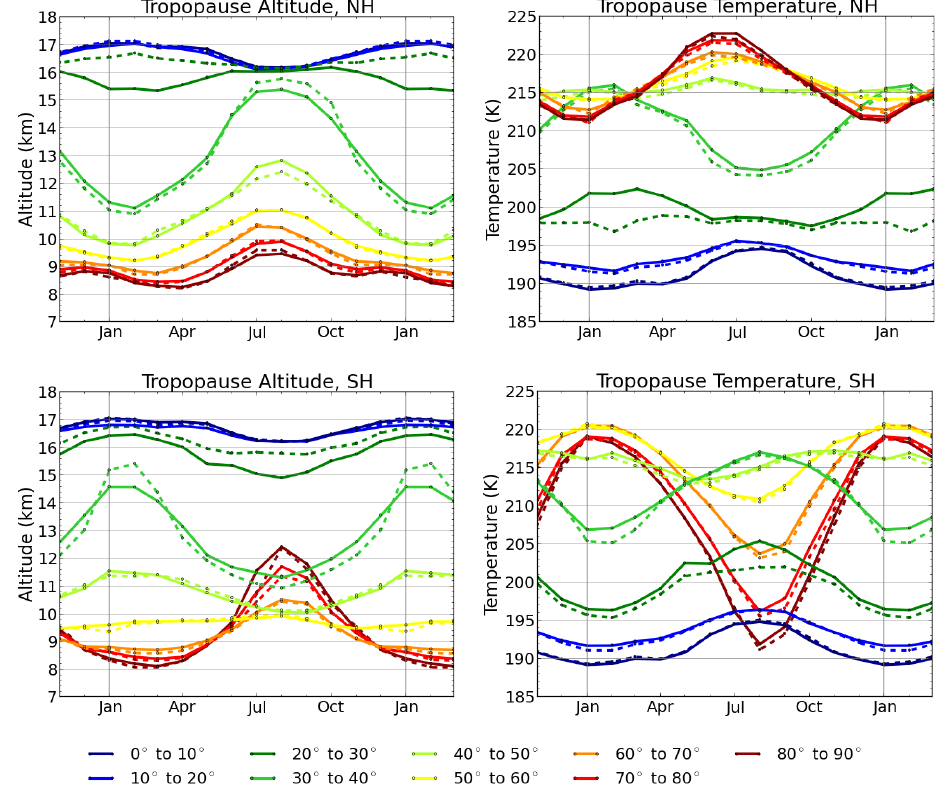
Figure 7. Annual cycle of mean (solid) and median (dashed) for tropopause altitude (left) and temperature (right) (top: NH; bottom: SH) using data from September 2001 to December 2013. Colors indicate different latitudinal bands. For clarity, two extra months are shown on either side of the full